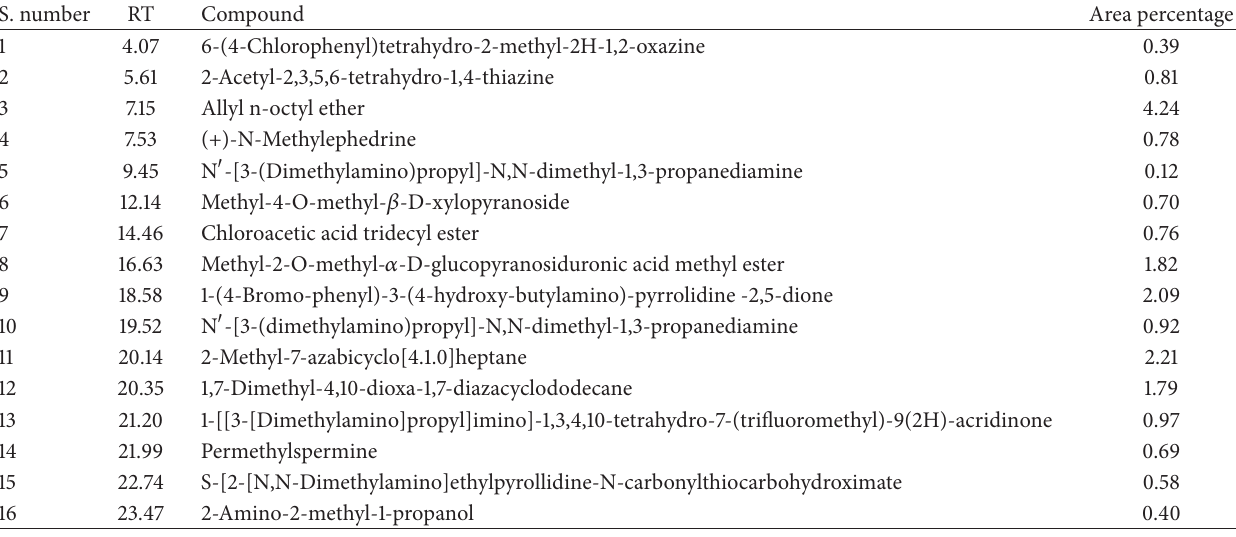
Table 5: Chemical profile identified by GC-MS analysis of ethanol extract of C . australe